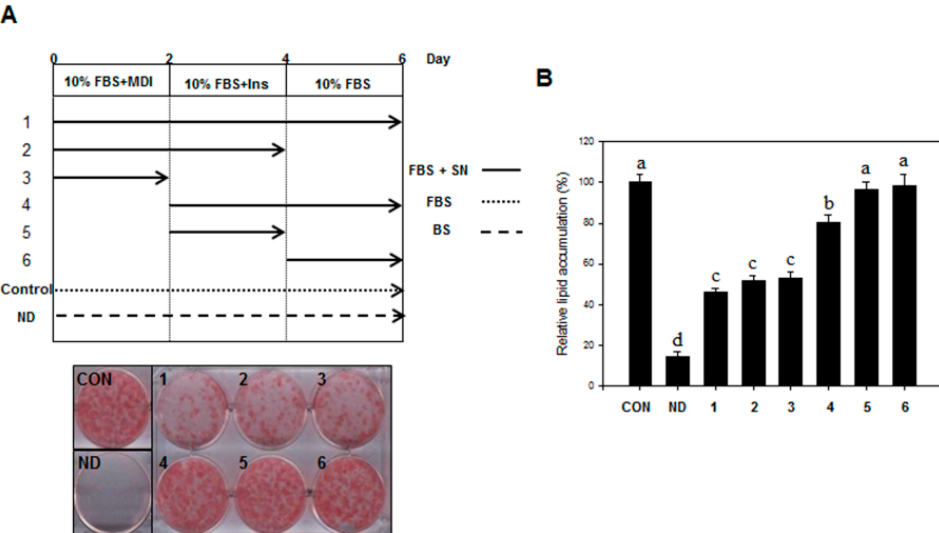
Figure 3. Effect of SN on mitotic clonal expansion during the early stages of adipogenesis. ( A ) Figure